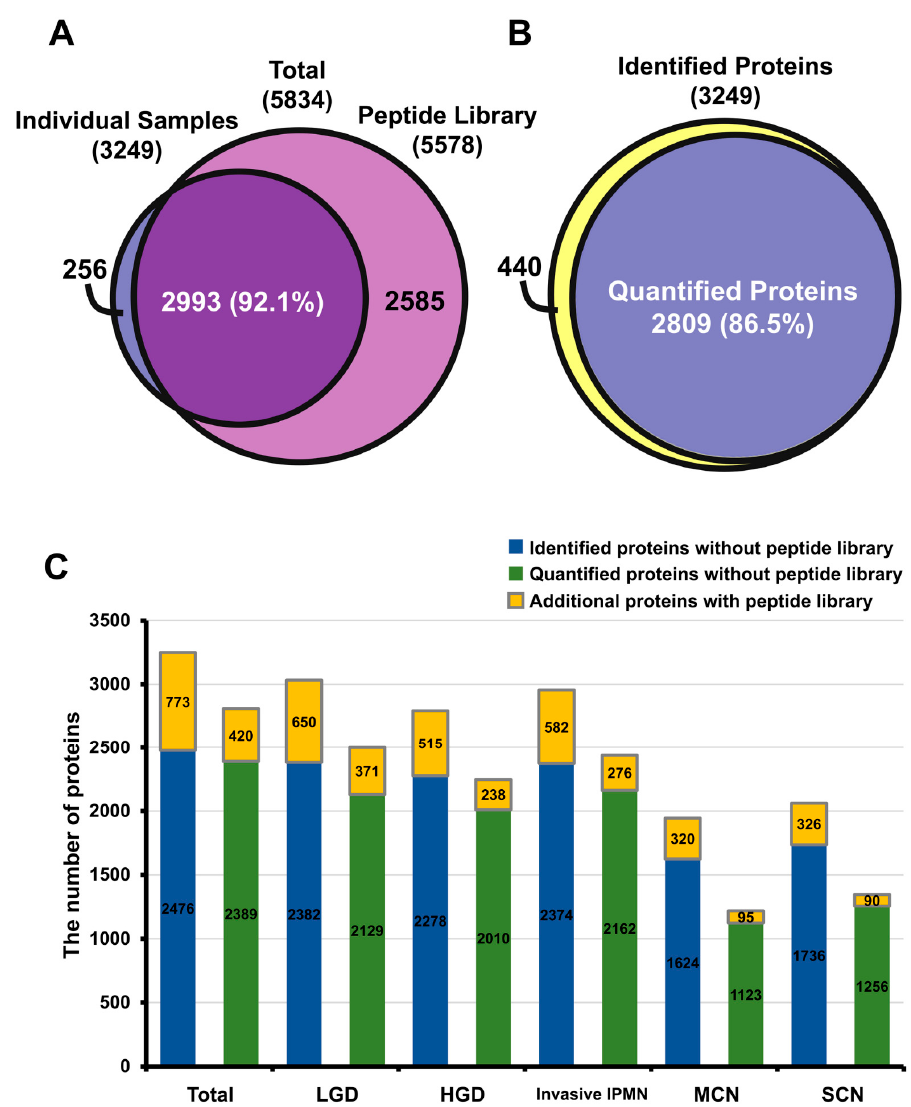
Figure 2. Comparison of protein identification and quantification in total dataset and in sample groups. ( A ) Among the 5834 proteins in the dataset, 5578 and 3249 were identified in the peptide library and individual samples, respectively, and 92.1% of the proteins overlapped. ( B ) Identified and quantified proteins in 30 individual cyst fluids; 86.5% of proteins were quantifiable. ( C ) Bar graph of the extra coverage enabled by the peptide library in the identified and quantified proteins of each sample